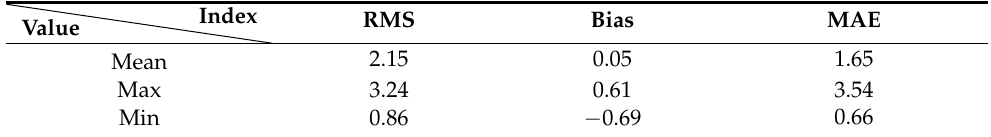
Table 2. Statistical results of RMS, Bias and MAE of PWV differences between GNSS and RS (54) in China over the period 2012 to 2020.